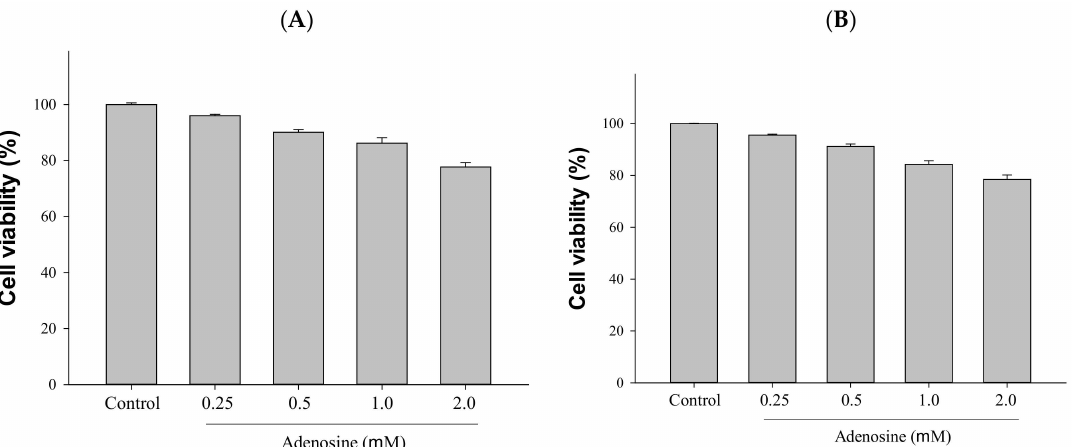
Figure 3. Cytotoxic effects of adenosine on HepG2 cells and 293T cells: ( A ) HepG2 cells; ( B ) 293T cells. Cells were treated with adenosine (0.25–2.0 mM) for 24 h, and cytotoxicity was measured using the MTT assay. Data are the means ± SD ( n = 3).